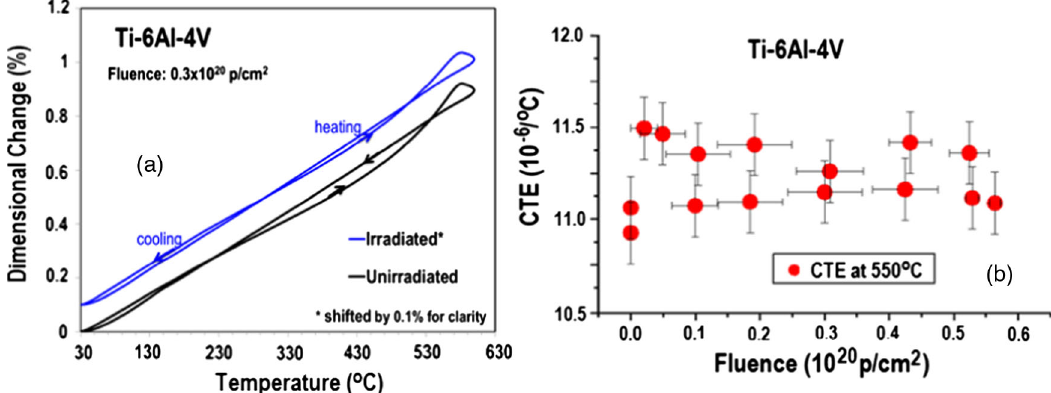
FIG. 20. Proton irradiation effects on (a) dimensional stability, (b) CTE at 550 °C of